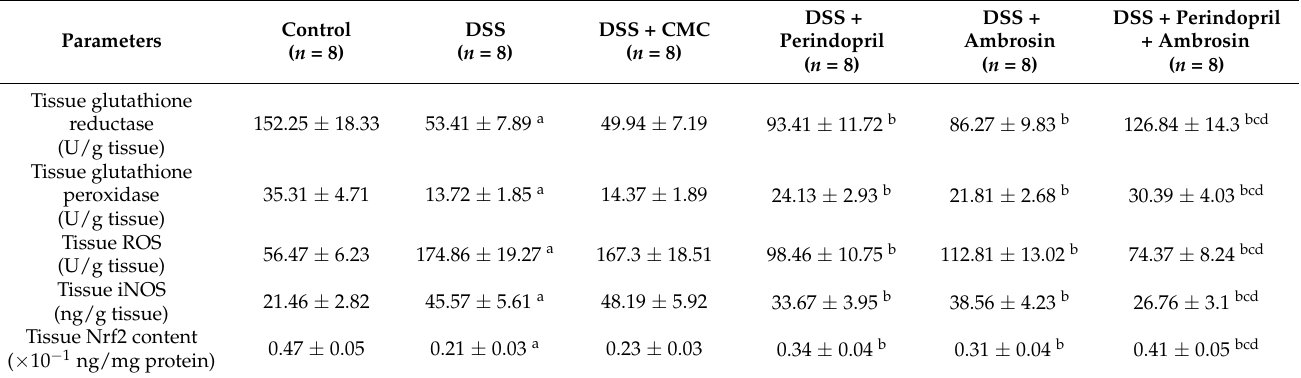
Table 2. Effect of perindopril with or without ambrosin on the antioxidant enzymes, ROS, and iNOS/Nrf2 signaling in the colonic tissues of DSS-treated mice (Mean ± SD).